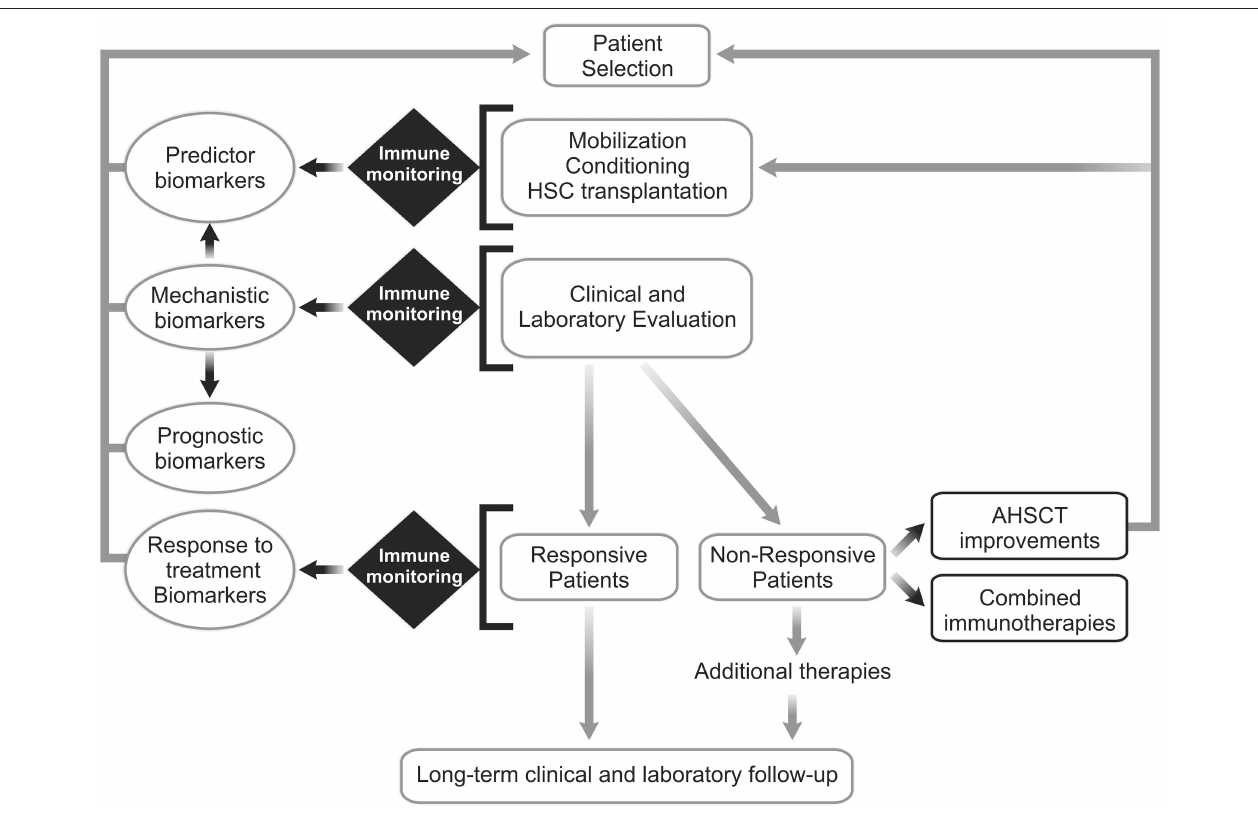
FIGURE 1 | Future directions for establishment of biomarkers of autologous hematopoietic stem cell transplantation for autoimmune diseases. Patients with autoimmune disease (AD) must be are selected to undergo autologous hematopoietic stem cell transplantation (AHSCT). Based on the clinical, laboratory and immune monitoring results, patients will be classified in “responsive” or “non-responsive” to AHSCT. Well-performed immune monitoring evaluations are essential to settle mechanistic biomarkers and reveal new prognostic, predictor and/or response to treatment biomarkers. Further, additional therapeutic interventions can be proposed to treat patients who do not respond sufficiently to transplantation as a single treatment or reactivate the disease after some period of remission. New approaches for improving AHSCT efficacy in AD patients and/or combined immunotherapies are warranted.